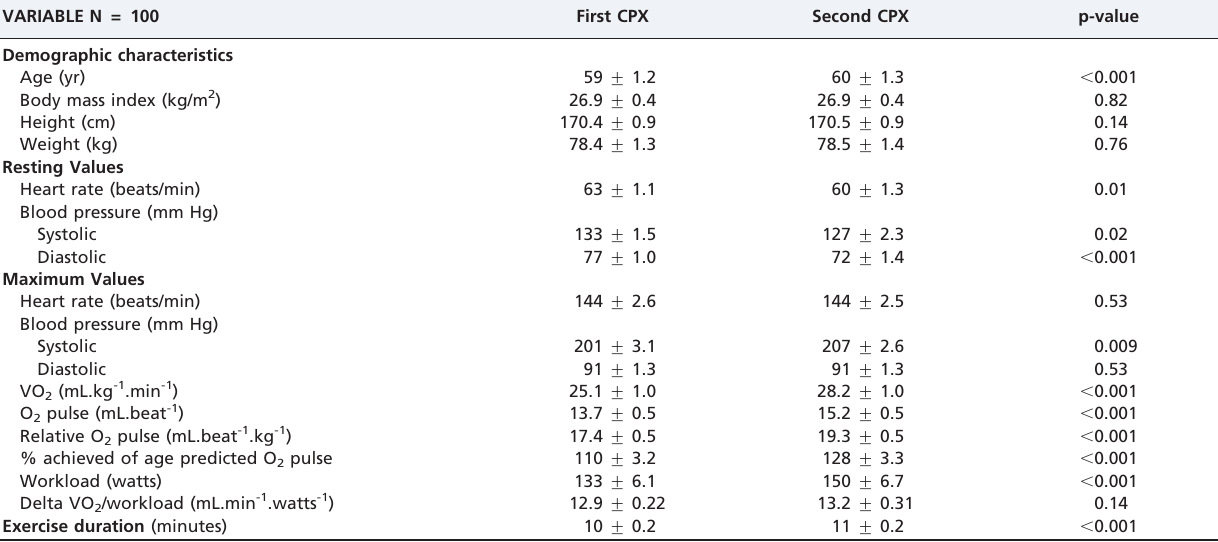
Table 2 - Demographic characteristics and exercise test